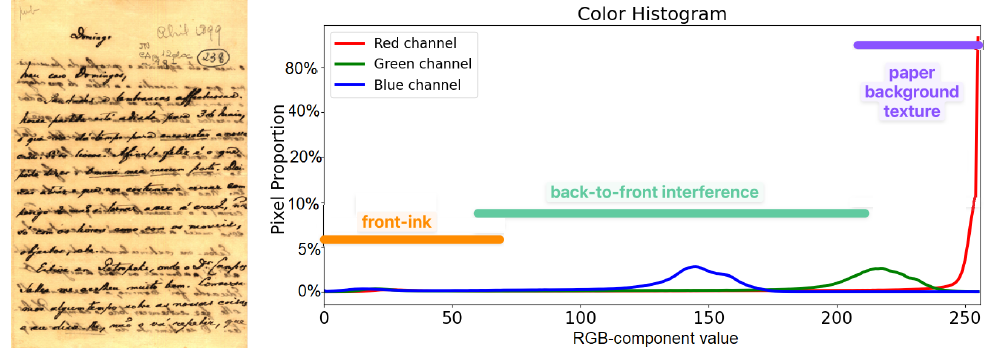
Figure 4. Pixel color distributions in a document image with strong back-to-front